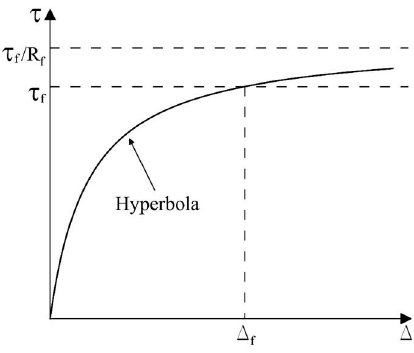
Figure 1. Schematic of hyperbolic curve.